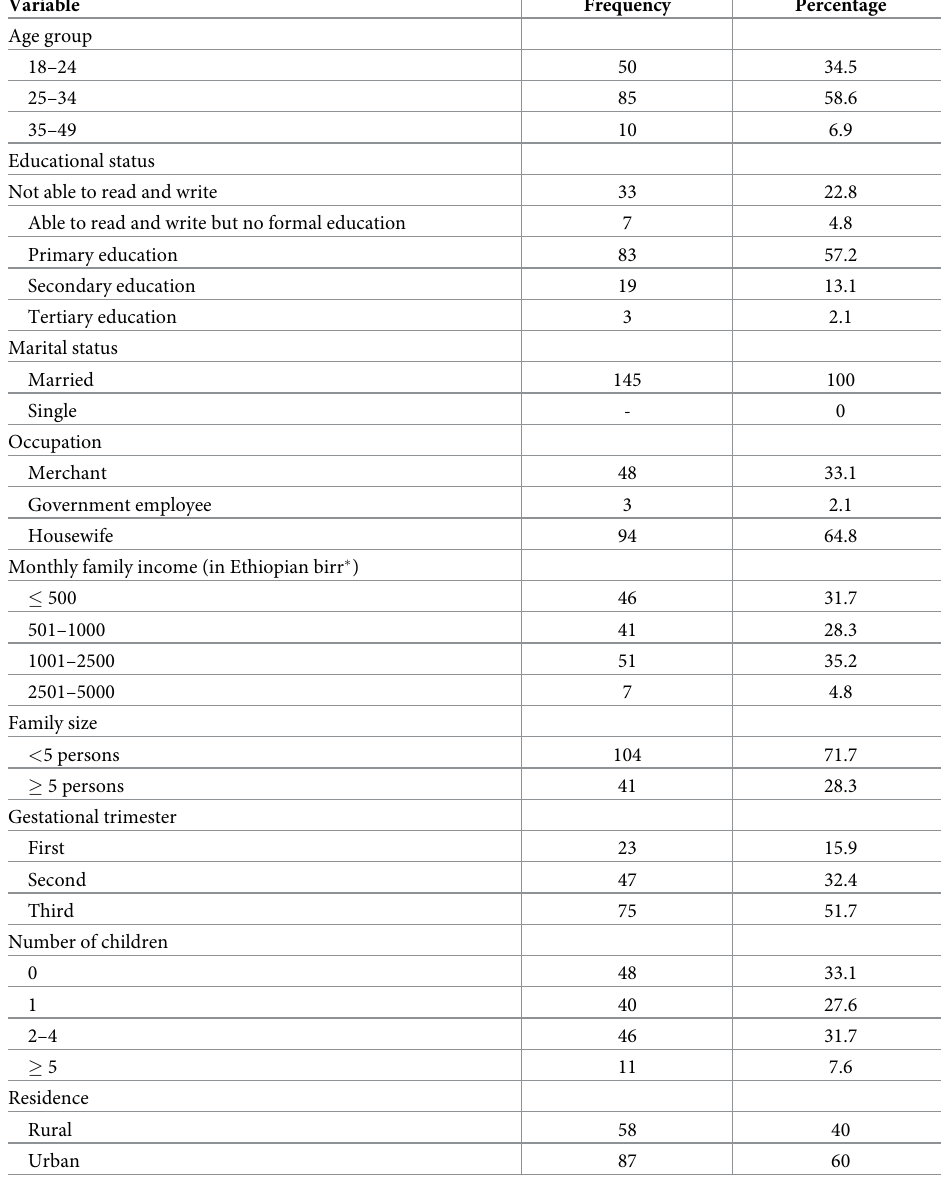
Table 1. Characteristics of pregnant women (N = 145) in BUNMAP cohort, Butajira, Ethiopia, February, 2019 (at the time of